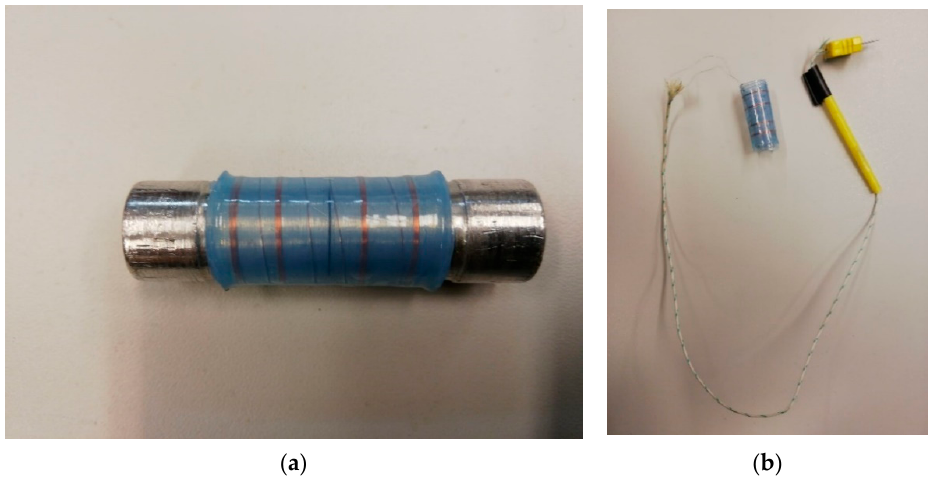
Figure 10. IOFEF joint sample preparation: ( a ) Without thermocouple on aluminum mold; ( b ) Complete IOFEF joint sample with 50 µ m K-type thermocouple.